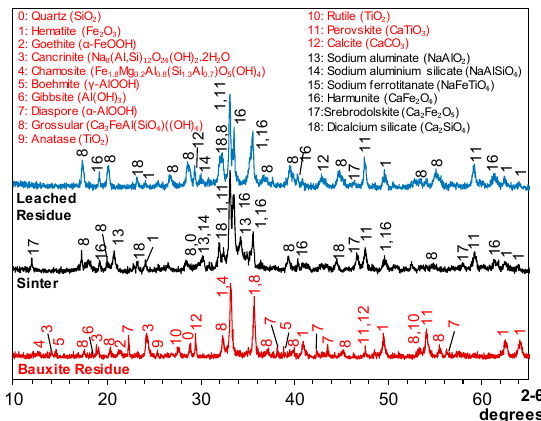
Figure 13. XRD of mineralogical phases for lime additions (20 g CaO/100 g bauxite residue, equivalent to 80% excess CaO addition for Ca 2 SiO 4 formation), and 50% excess soda at 900 °C and for 2 h. Red font: Existing minerals in bauxite residue; black font: Transformed sinter and leached minerals.